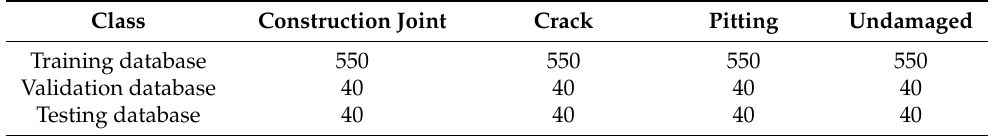
Table 1. Composition of dataset extracted from SDNET 2018 for GAN-based data